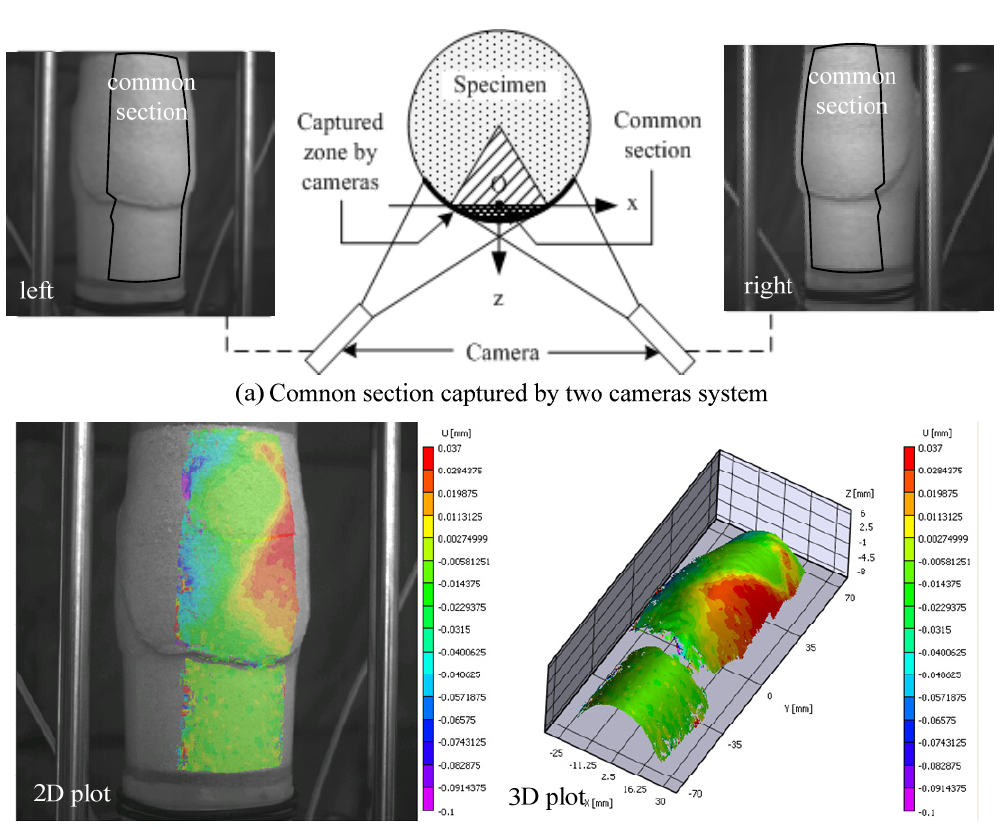
Figure 10. Common section captured by the VIC ‐ 3D two ‐ camera system ( a ) and displacement fields in 2 ‐ D and 3 ‐ D ( b ).